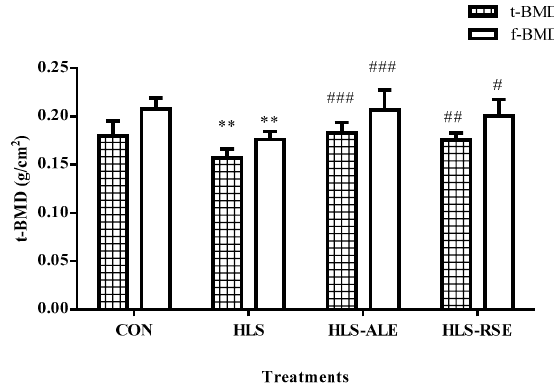
Figure 2. Bone mineral density of proximal tibia (t-BMD) and distal femur (f-BMD) within various treatment groups (g/cm 2 ). CON: control group; HLS: hindlimb suspended group; HLS-ALE: group administrated with alendronate (2 mg/kg/day); HLS-RSE: group administrated with Radix Scutellariae extract (50 mg/kg/day). Values are presented by means ± SD, n = 6, * versus CON group: ** p < 0.01; # versus HLS group: # p < 0.05; ## p < 0.01; ### p < 0.001.